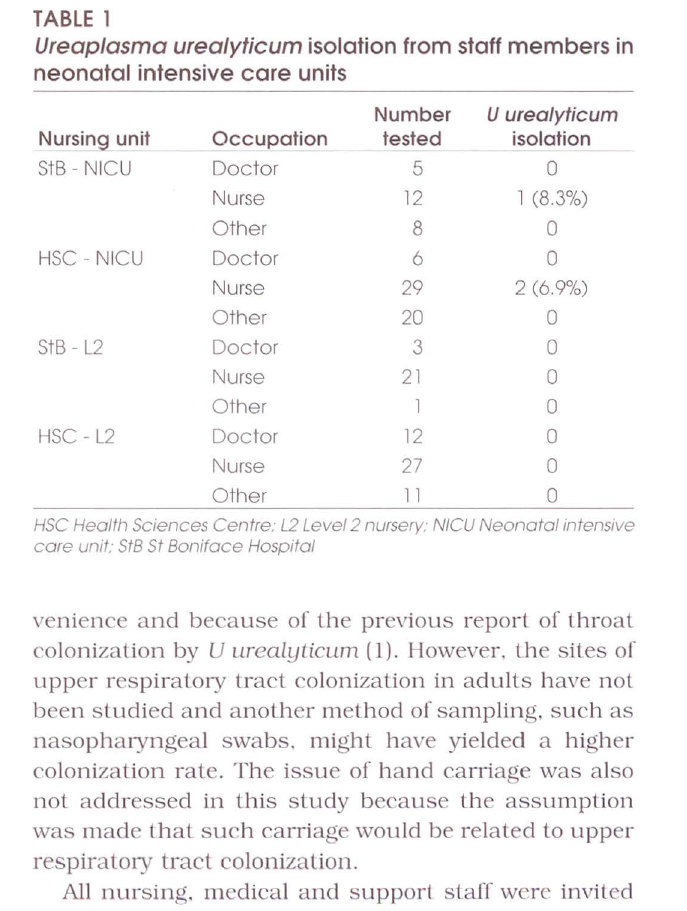
Ureap/asma urea/yticum isolation from staff members in neonatal intensive care